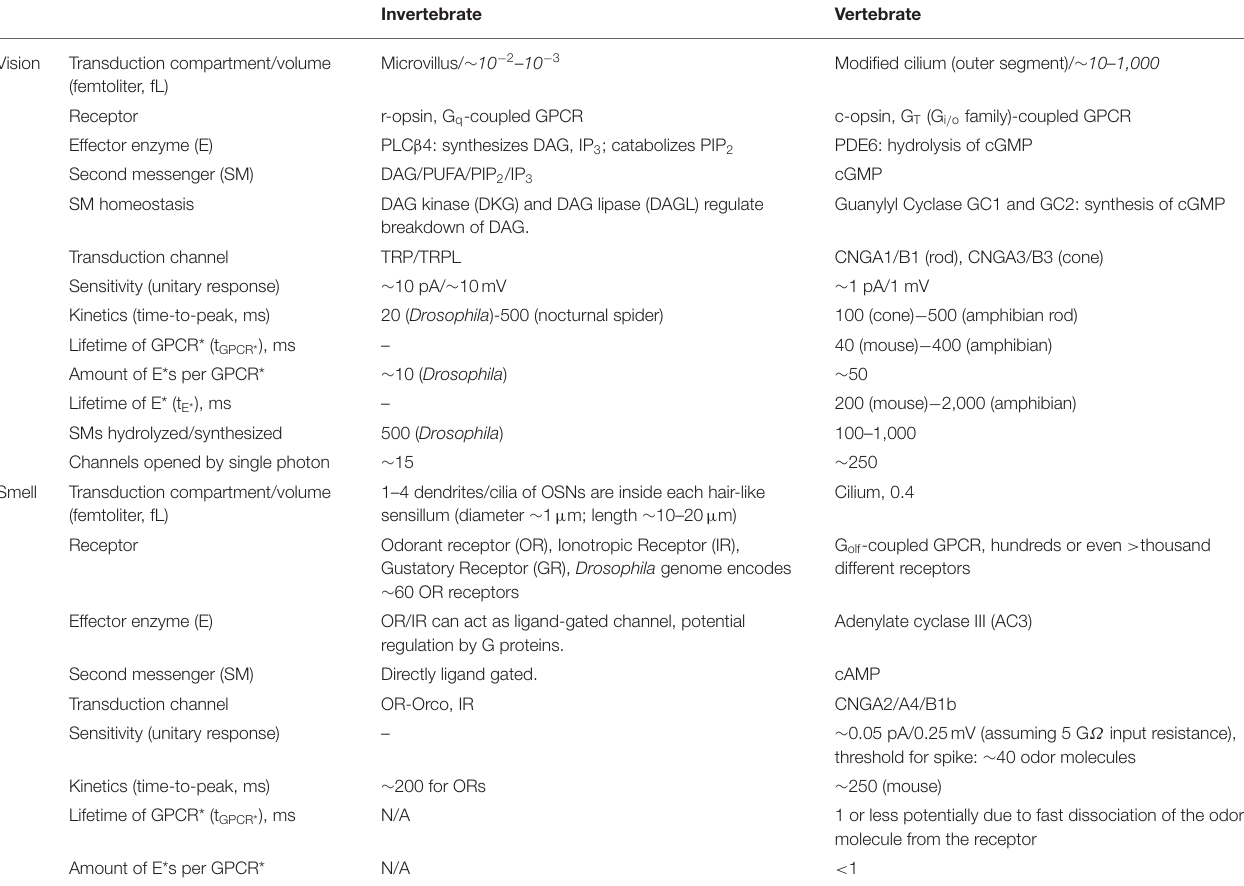
TABLE 1 | Overview and comparison table of the transduction cascades in vertebrates and invertebrates in vision and olfaction.